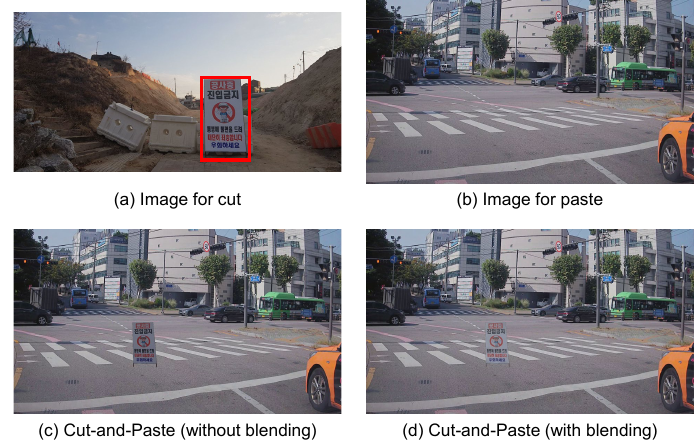
Figure 7. Effect of blending. Using the construction sign image in ( a ) and the road image in ( b ), we synthesize the training image via cut-and-paste. As shown in ( c ), however, the artifact seems prominent because of the color difference between the construction sign and the road. This problem is mitigated by blending, as shown in ( d